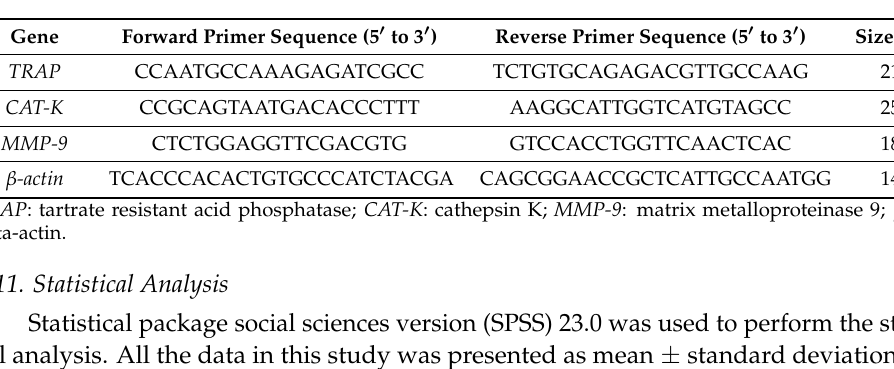
Table 1. Primer sequences used in real-time